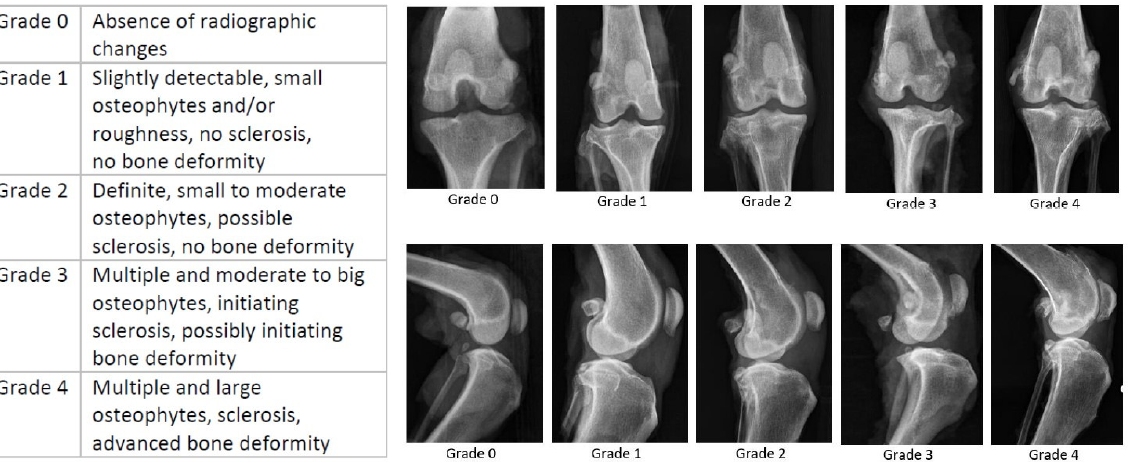
Figure 1. Modified radiographic osteoarthritis grading system for dogs [17] according to the Kellgren–Lawrence system [18], and exemplary pictures for each osteoarthritis grade. In this study, only dogs with grade 0 and grade 1 were included.